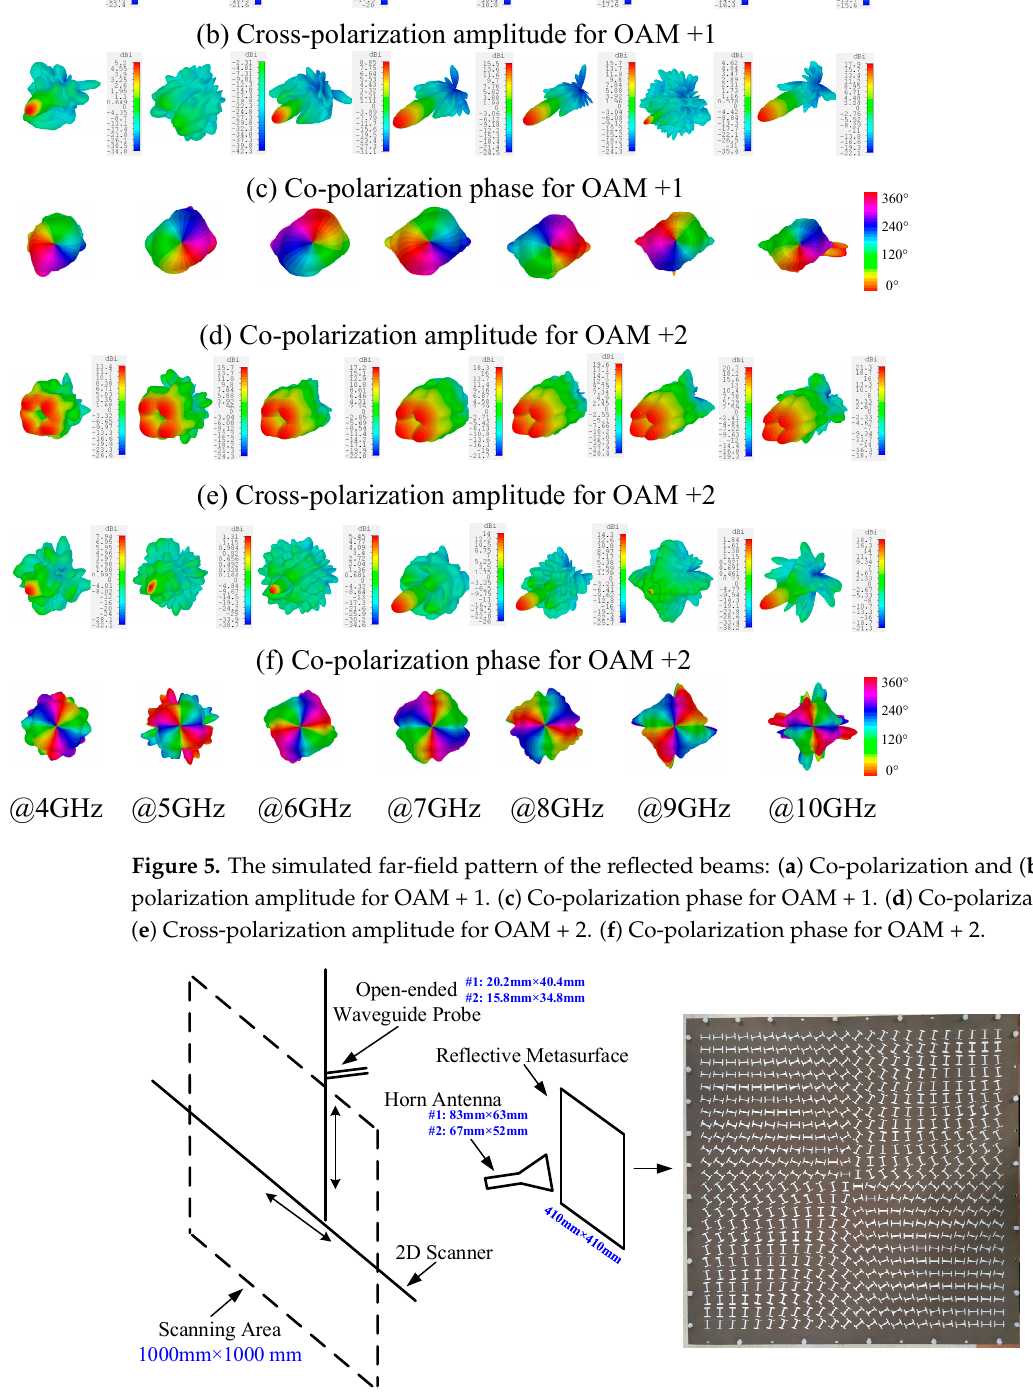
Figure 6. The fabricated metasurface and the near field measurement settings.